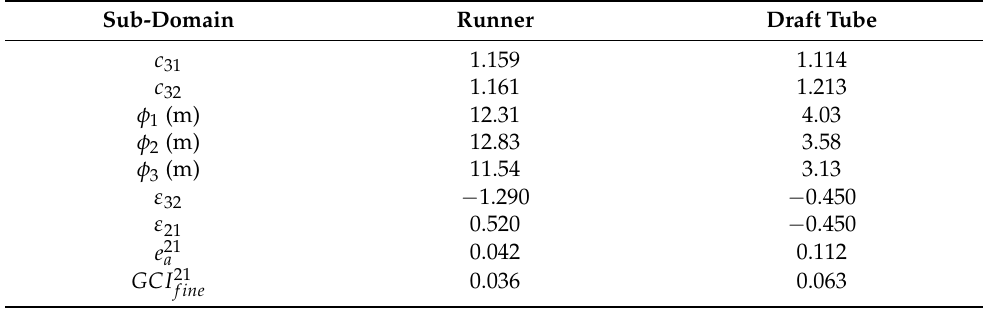
Table 5. Spatial discretization error and numerical uncertainties in runner and draft tube meshes.